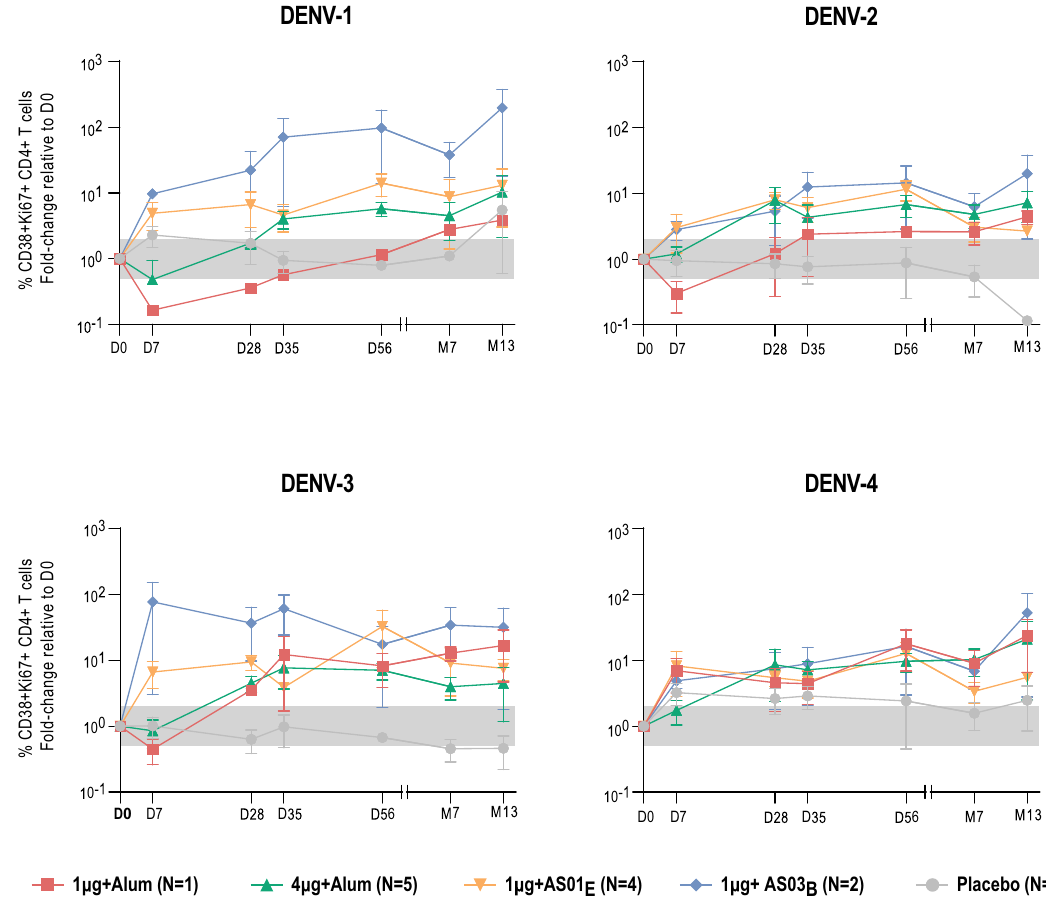
Fig. 4 Median fold change in the percentage of activated CD38 + Ki67 + CD4 + T cells among total CD4 + T cells. Changes are relative to day 0 (pre-vaccination) values, after 6 – 7 days in vitro culture with combined DENV capsid/pre-membrane and envelope region peptide pools, following DPIV vaccination of dengue-naive adults (adapted according-to-protocol cohort for immunogenicity subset). Error bars represent standard errors. D, day; D0, pre-vaccination; D7, 7 days post-dose 1; D28, 28 days post-dose 1; D35, 7 days post-dose 2; D56, 28 days post-dose 2; DENV, dengue virus; DPIV, tetravalent dengue puri fi ed inactivated vaccine; M, month; M7, 6 months post-dose 2; M13, 12 months post-dose 2; N, number of participants, expressed as a range. The gray box indicates + / −